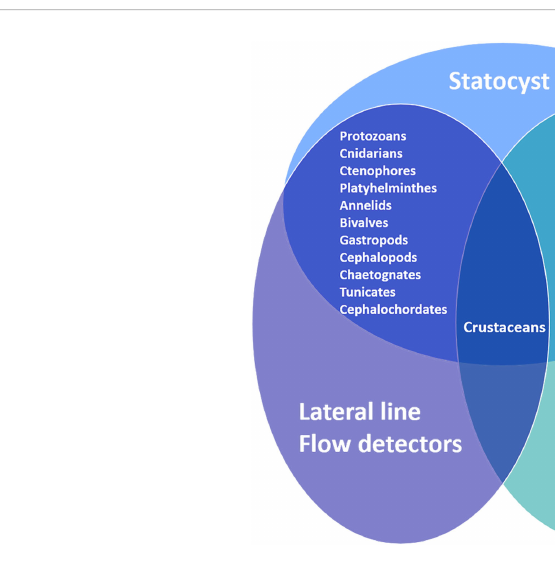
FIGURE 4 Marine Invertebrate sound sensory